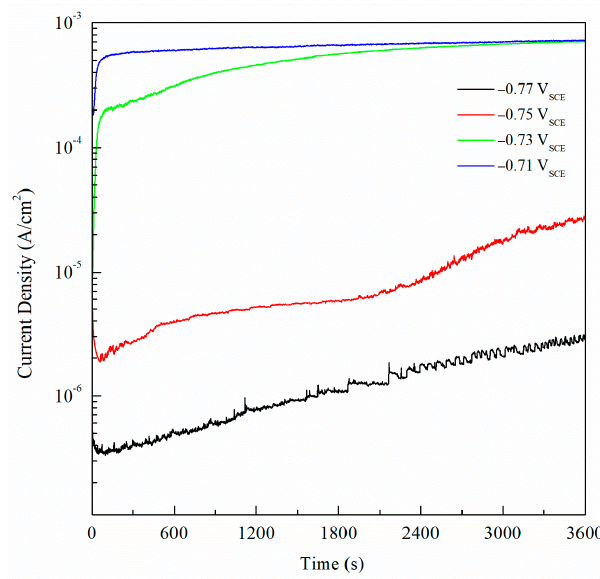
Figure 16. Current transient data for the AA5083 sensitized at 150 °C for 30 days polarized at − 0.77, − 0.75, − 0.73 and − 0.71 V SCE .